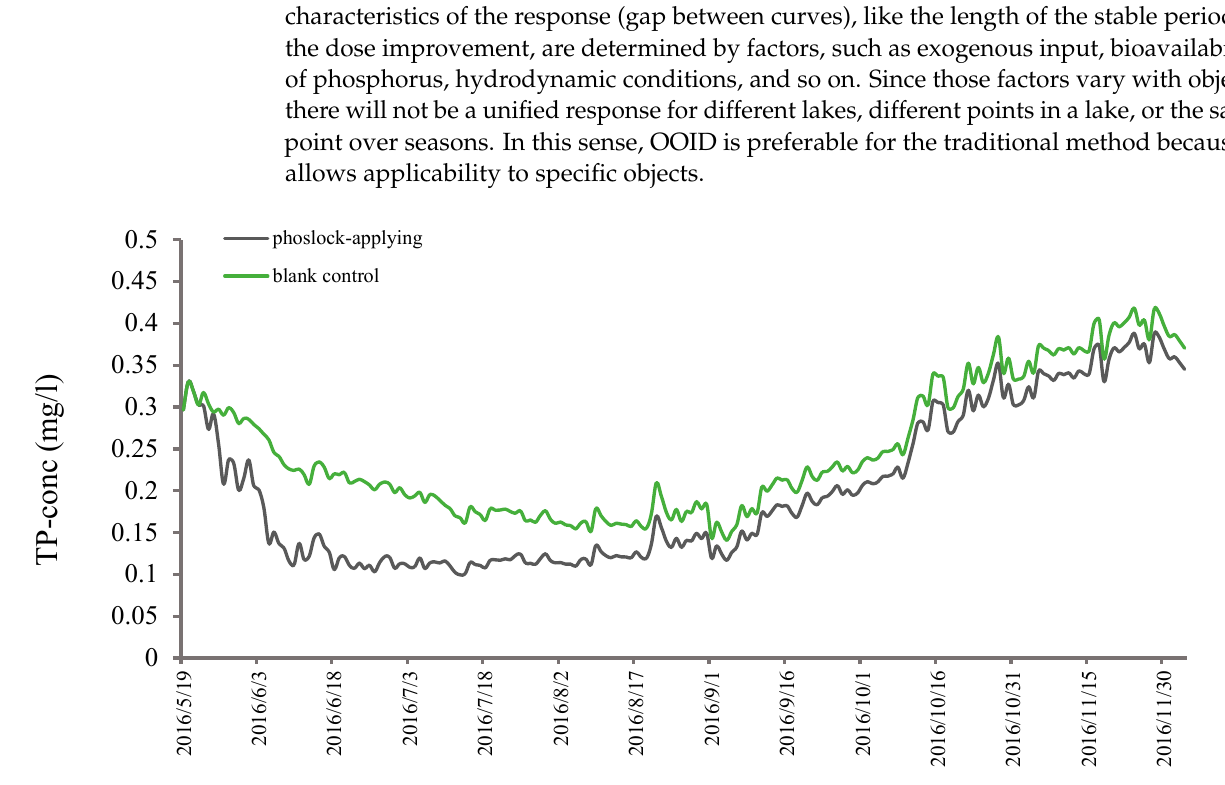
Figure 7. Time series graph of total phosphorus (TP) concentration for a typical scenario of Phoslock application (base0, T2, Table 2. A0, 300 t/d).